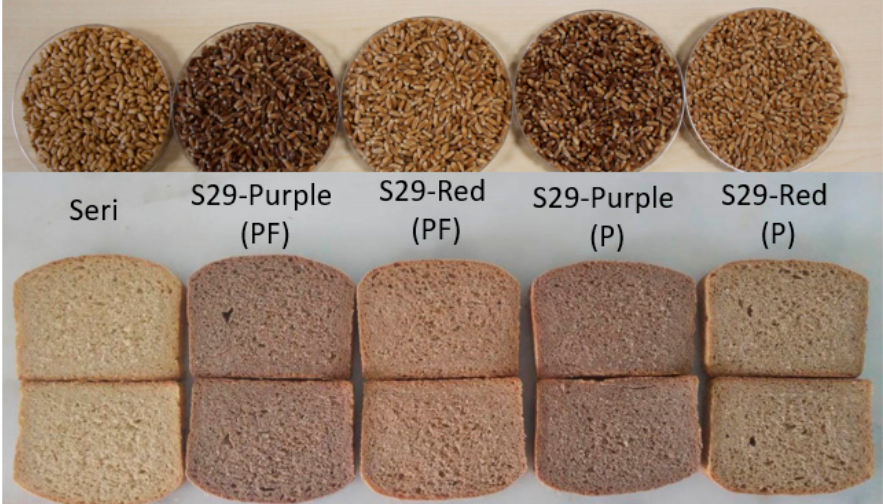
Figure 2. Grain and bread made from Seri (check) and purple grain isogenic lines, Konya, Turkey,